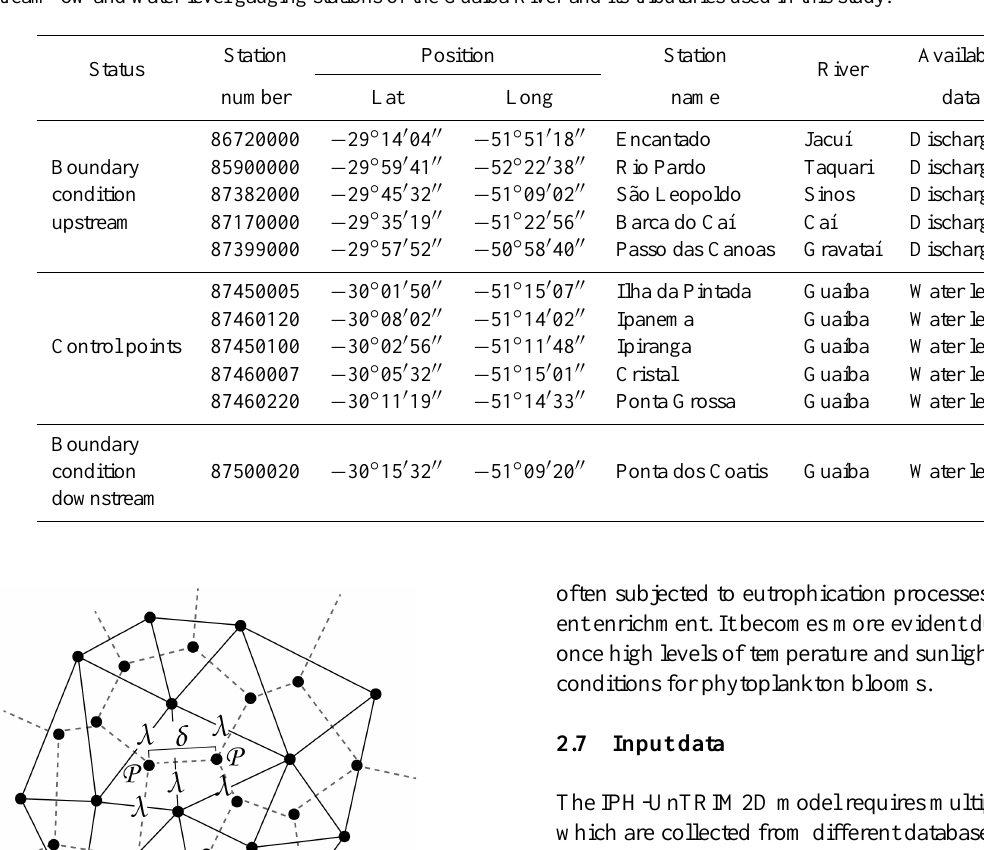
Table 1. Streamflow and water level gauging stations of the Guaíba River and its tributaries used in this study.